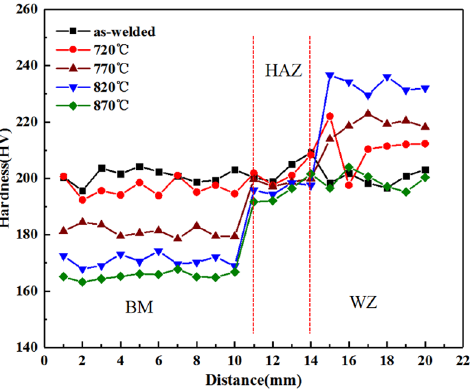
Figure 16. Hardness distribution of welded joints at different heat treatment temperatures.